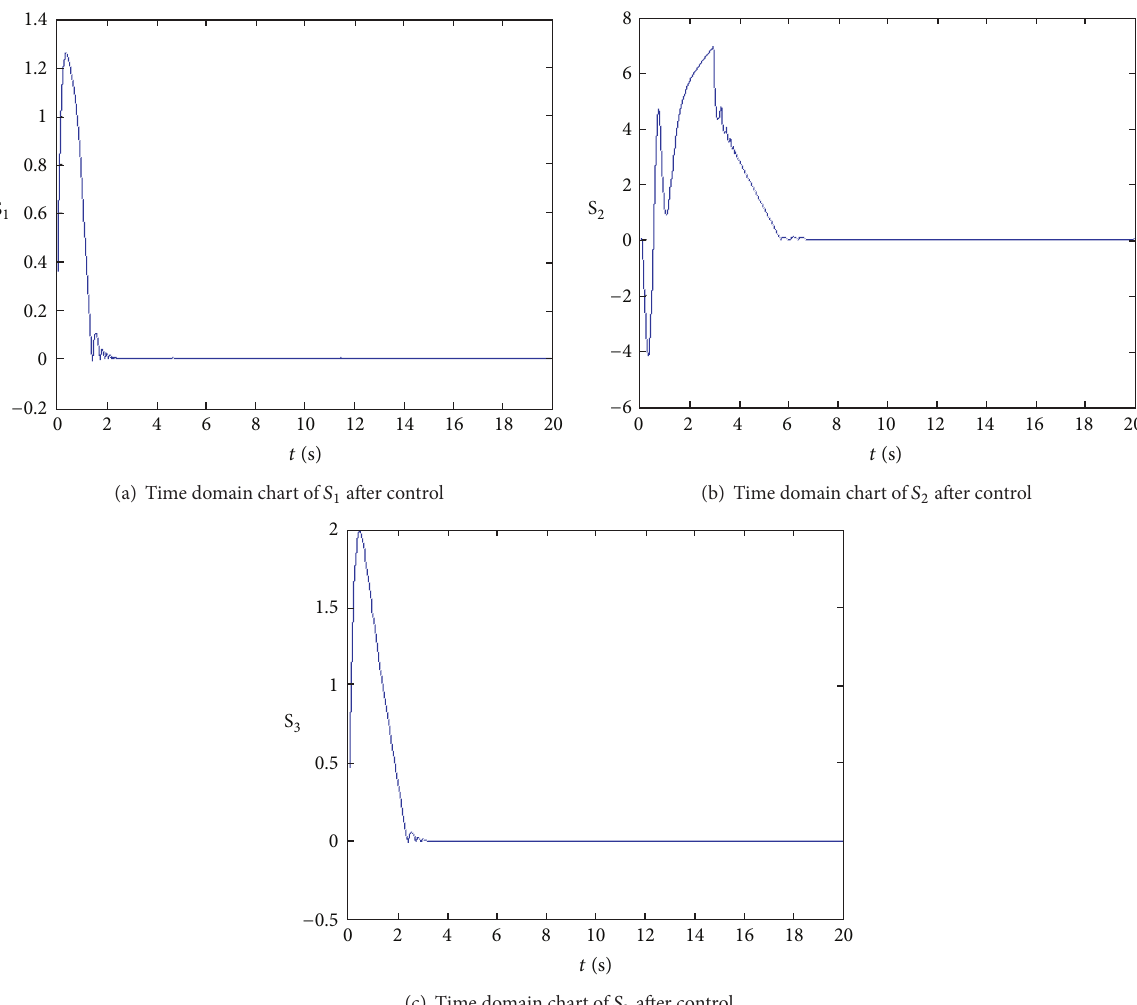
(c) Time domain chart of 𝑆 3 after control Figure 12: Time domain charts of sliding surfaces after